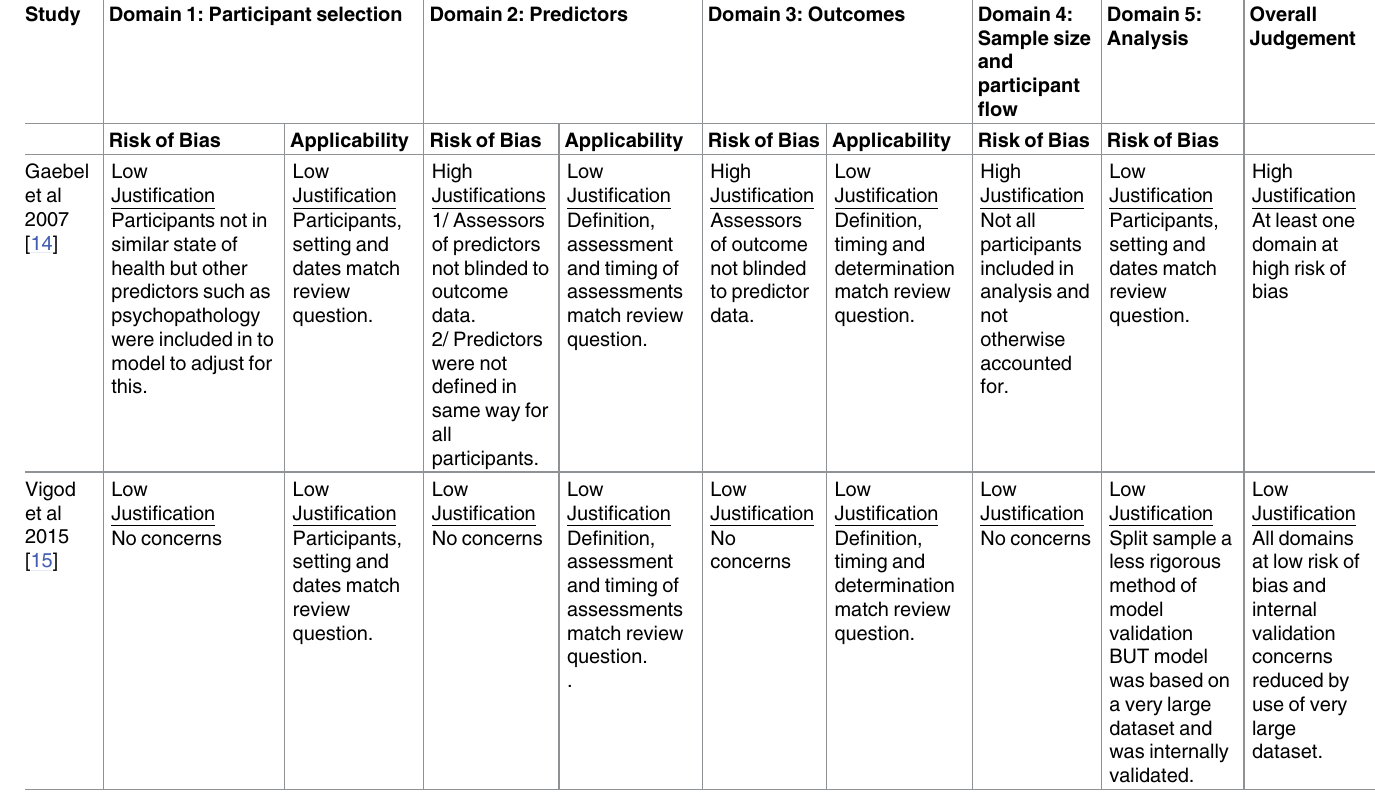
Table 3. Quality assessment of studies included in the systematicreview–areas of concern using PROBAST